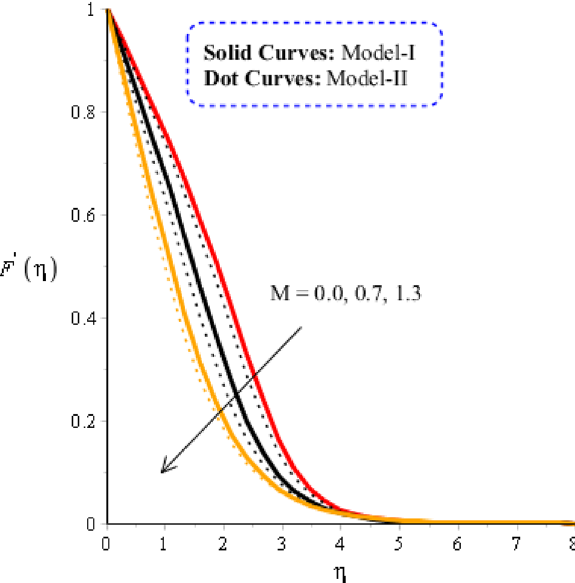
Figure 4. Graphical impact of M on velocity distribution when α = 0.5, m = 0.3, Re = 4.0, we = 3.0, Pr = 206,